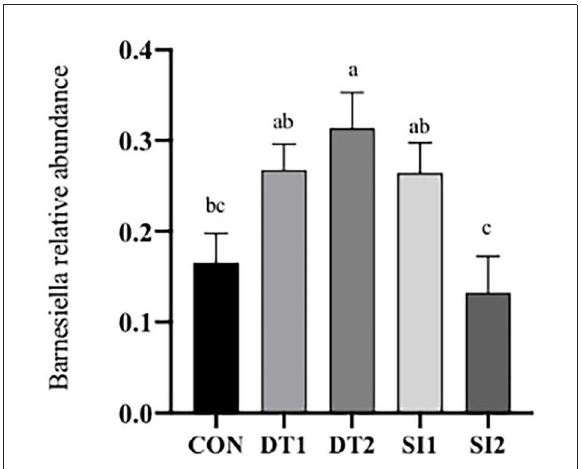
FIGURE7 Effects of dietary dandelion tannins or soybean isoflavones on cecal microbiota at the genus level. a , b , c Marks indicate statistically significant differences ( P <